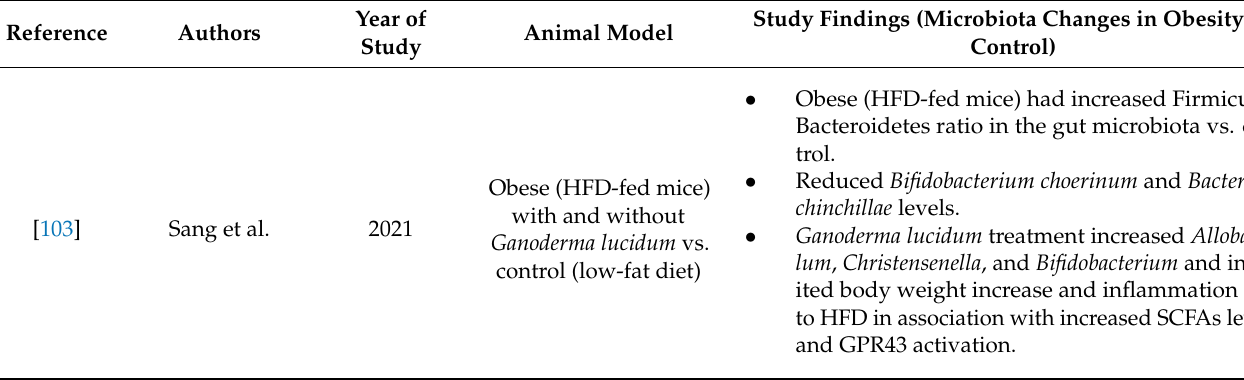
Table 5. Animal studies of the gut microbiota in